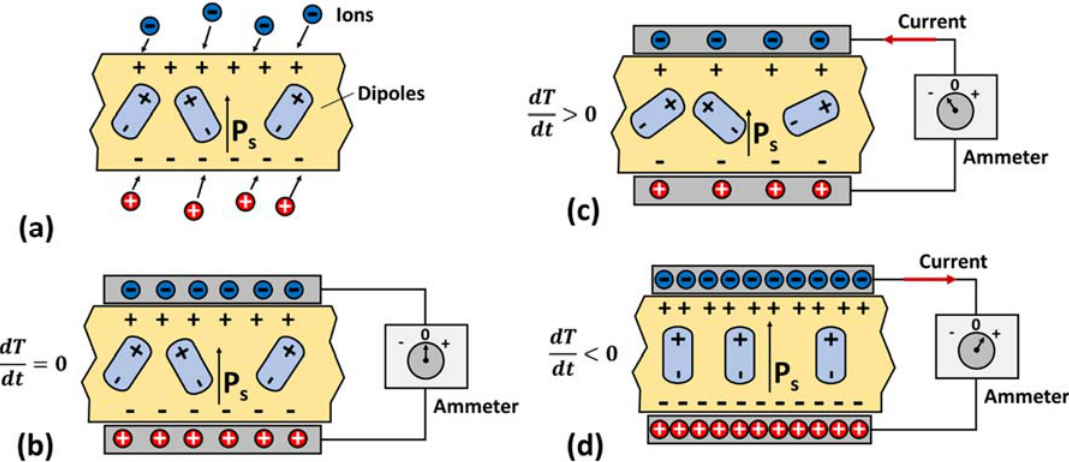
Figure 11. Conceptual model of pyroelectric generator. ( a ) Pyroelectric materials have dipole moments that add up to provide a spontaneous polarization; ( b ) Pyroelectric material between the two conductive electrodes of a capacitor. Temperature is held constant and there is no current in the steady state; ( c ) Increase in temperature decreases spontaneous polarization; ( d ) Decrease in temperature increases spontaneous polarization. Cyclic temperature change in pyroelectric materials generates alternating current. Figure reconstructed from ref. [96].